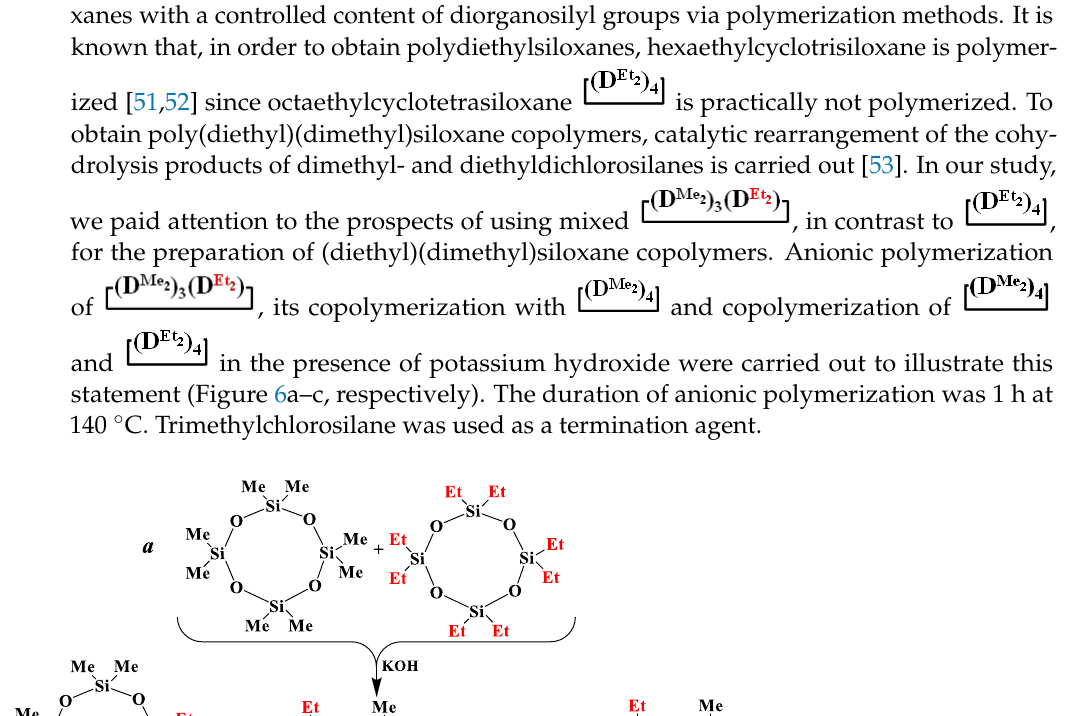
Figure 6. Polymerization schematics of and ( a ), of and ( b ) and of ( c ).